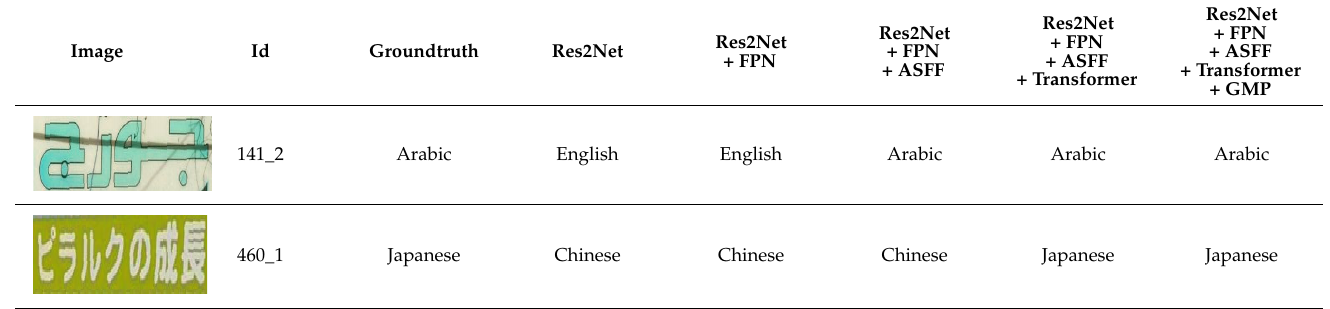
Table 6. Two script identification examples illustrating the gradual change from wrong to correct. These five methods correspond to the five methods in the ablation experiments in Table 3, respectively.